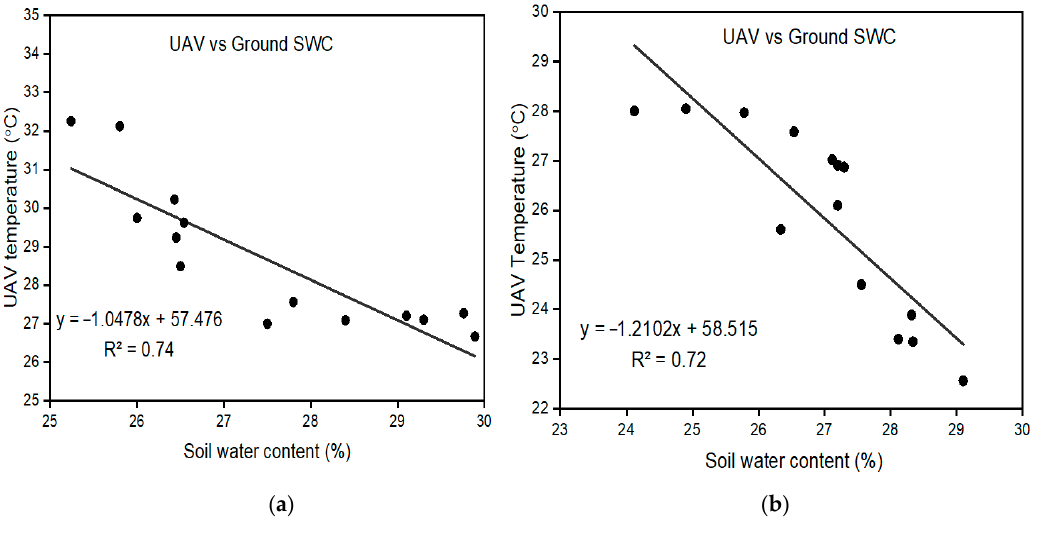
Figure 10. Relationship between the UAV LST and SWC, ( a ) DOY 230, ( b ) DOY 245.